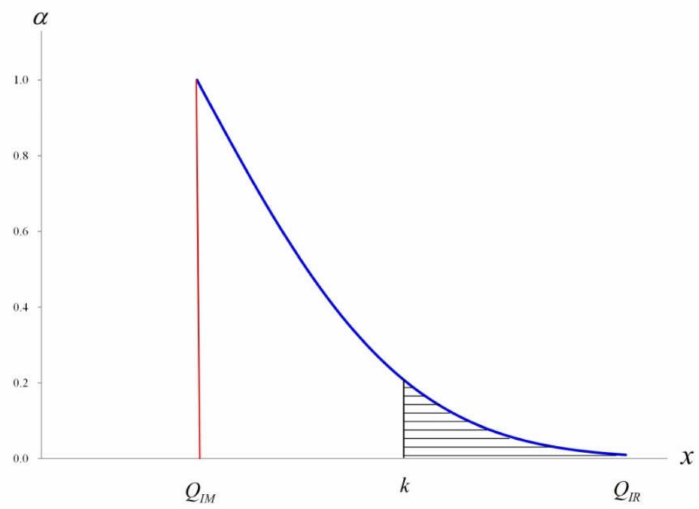
Figure 1. Schematic diagram of Membership function η ( x ) with vertical line x = k